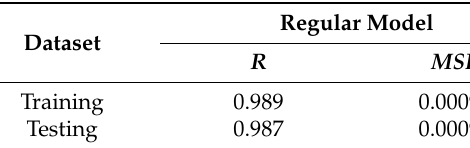
Figure 17. Simulated and ANN’s predicted CDAF for a regular building model. Table 6. Performance of ANN